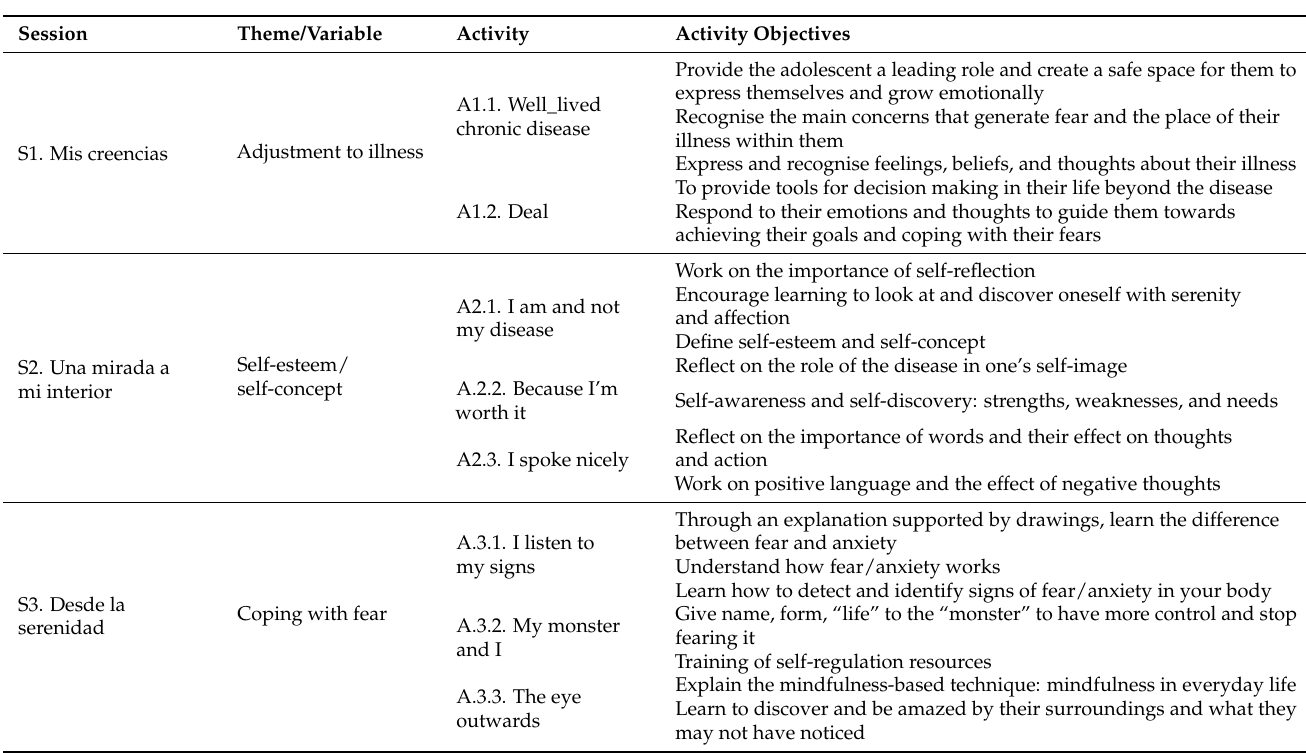
Table 3. Content of 10Vida